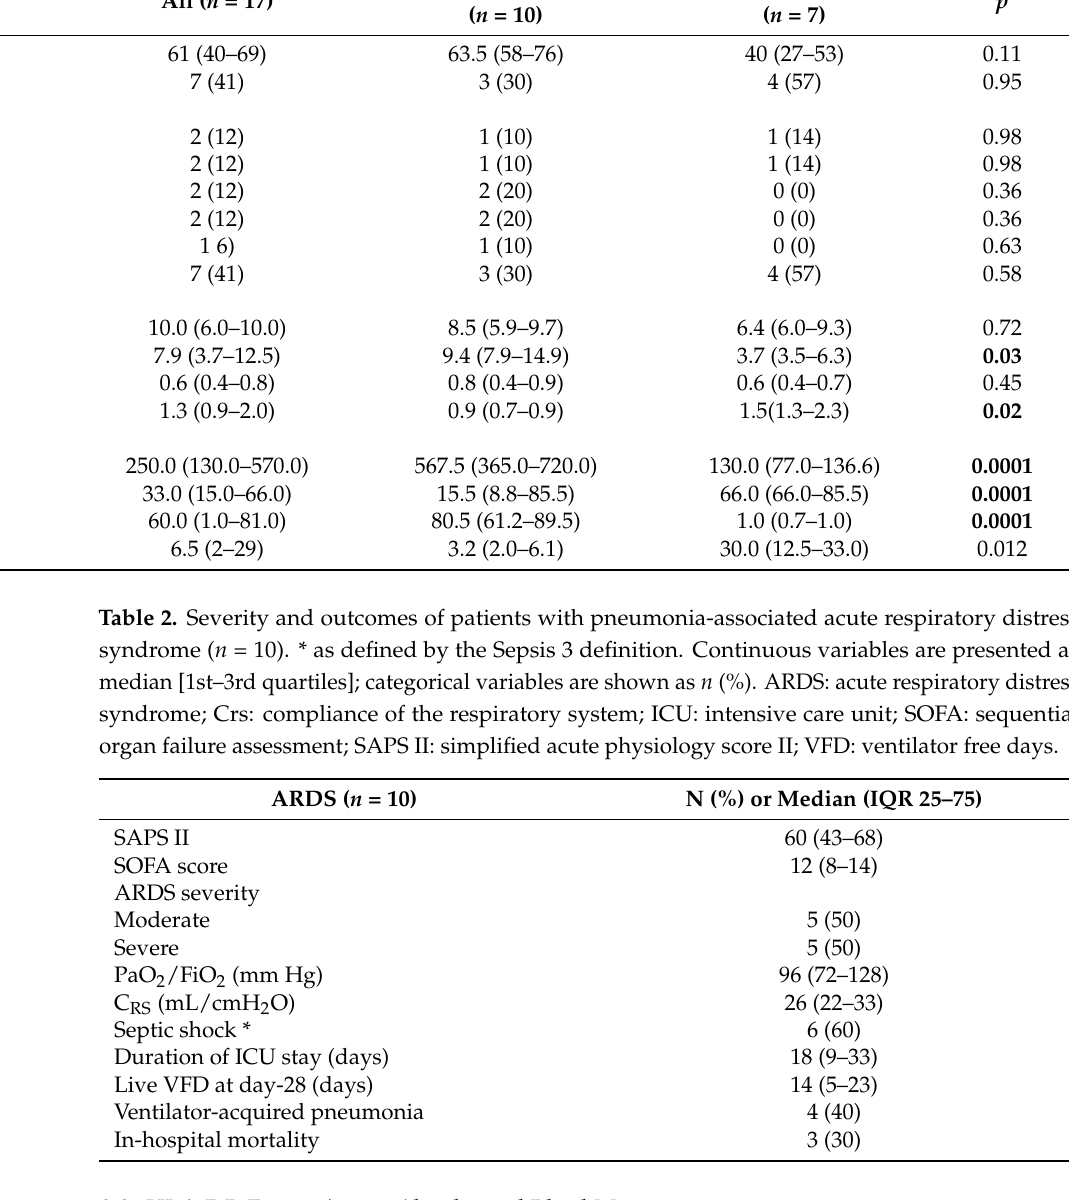
Table 1. Demographics and clinical and biological features of patients with pneumonia-associated acute respiratory distress syndrome ( n = 10) and non-ARDS controls ( n = 7) upon BAL fluid sampling. Continuous variables are presented as median [1st–3rd quartiles]; p values come from the Mann-Whitney test; categorical variables are shown as n (%); p values come from the chi2 or the Fisher exact test, as appropriate. ARDS: acute respiratory distress syndrome; COPD: chronic obstructive disease; WBC: white blood cell. Bolded results are significant at the p < 0.05 level.